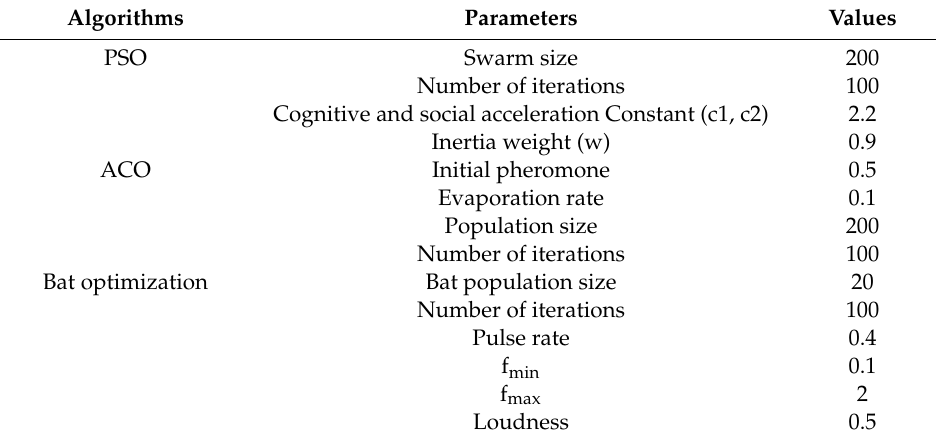
Table 1. Optimization parameters.